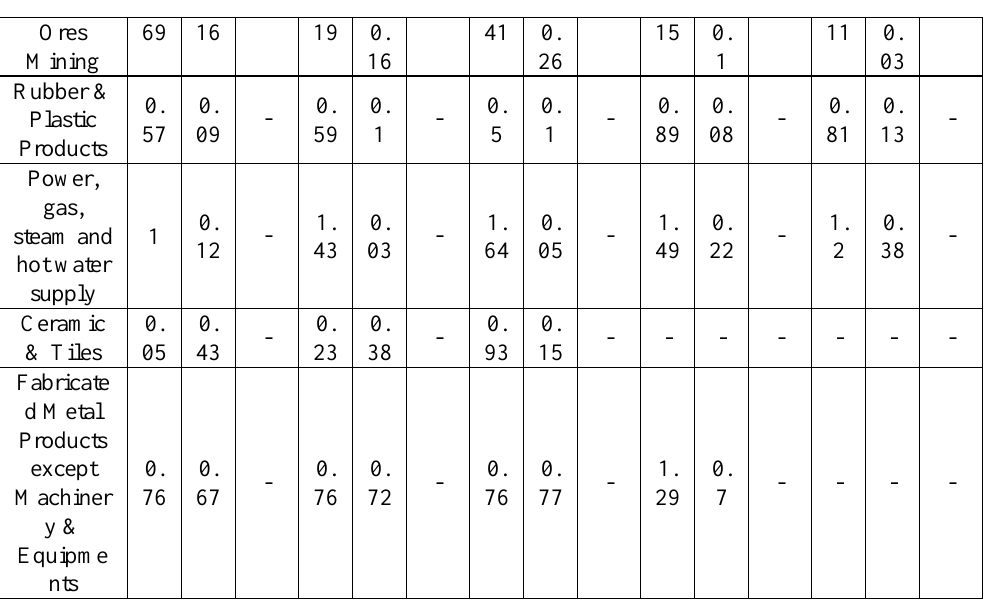
Table 2 . continued - Beta of Assets, Beta of Growth Opportunities and the difference